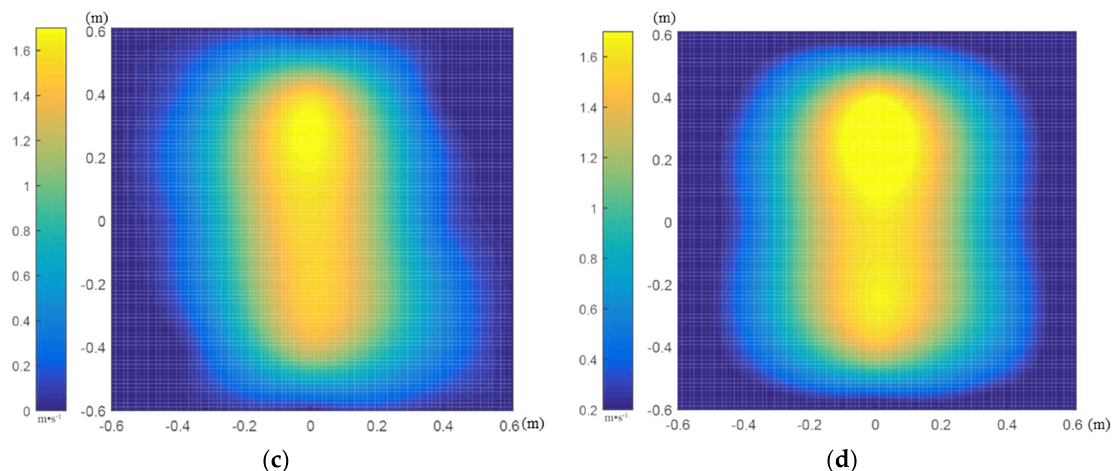
Figure 7. Three-dimensional tester interpolation results when the DJI phantom drone (unmanned aerial vehicle, UAV) hover-flight height is 1 m from 3D airflow field testers. ( a ) X-axial velocity profile; ( b ) Y-axial velocity profile; ( c ) Z-axial velocity profile; ( d ) combined velocity profile.